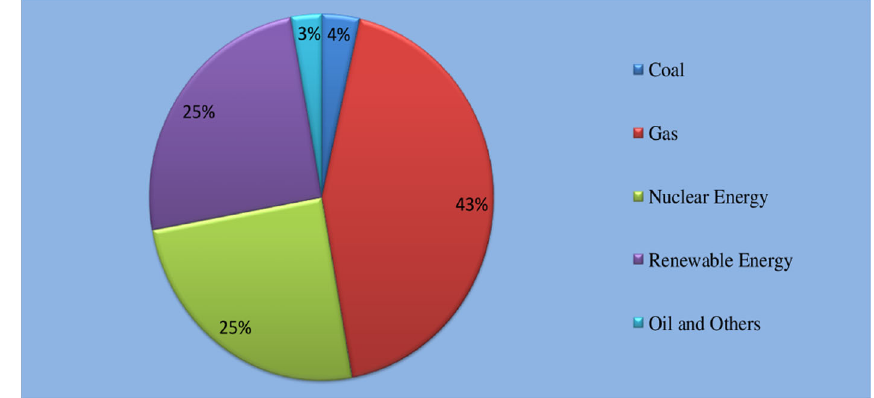
Fig. 1 Percentage of Electric Power Produced from Various Energy Sources in 2016 [8, 10]